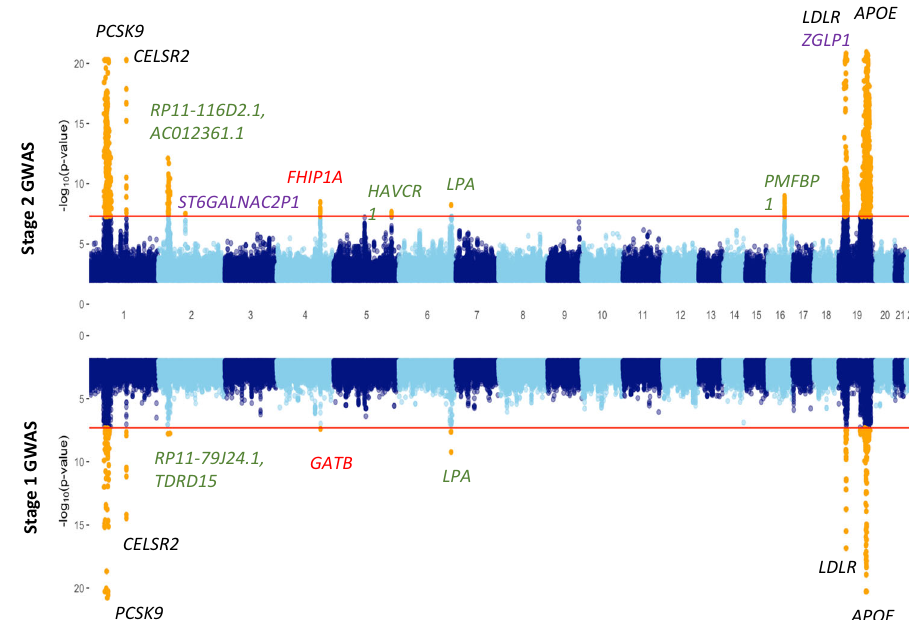
Fig. 2 Genome-wide associations for LDL-C. Miami plot showing summary data for Stage 1 GWAS (AWI-Gen, downward facing, N = 10,603) and Stage 2 GWAS (meta-analysis of AWI-Gen and four African cohorts, upward facing, N = 23,718). P -values (two-tailed, not adjusted for multiple comparisons, calculated using BOLT-LMM for Stage 1 GWAS and METASOFT for Stage 2 GWAS) are truncated at 10 − 20 for clarity. The red horizontal lines show the genome-wide signi fi cance threshold (5 × 10 − 8 ) and SNPs with P -values below this threshold are shown in orange. The loci corresponding to the region showing novel association in Stage 1 and Stage 2 GWAS are indicated in red. Other possible novel loci that reached genome-wide signi fi cance only in the Stage 2 analysis are shown in purple. Known LDL-C associated regions that were represented by novel lead SNPs are shown in green. Loci represented by lead SNPs that are well-known for LDL-C associations across multiple studies, including ours, are shown in